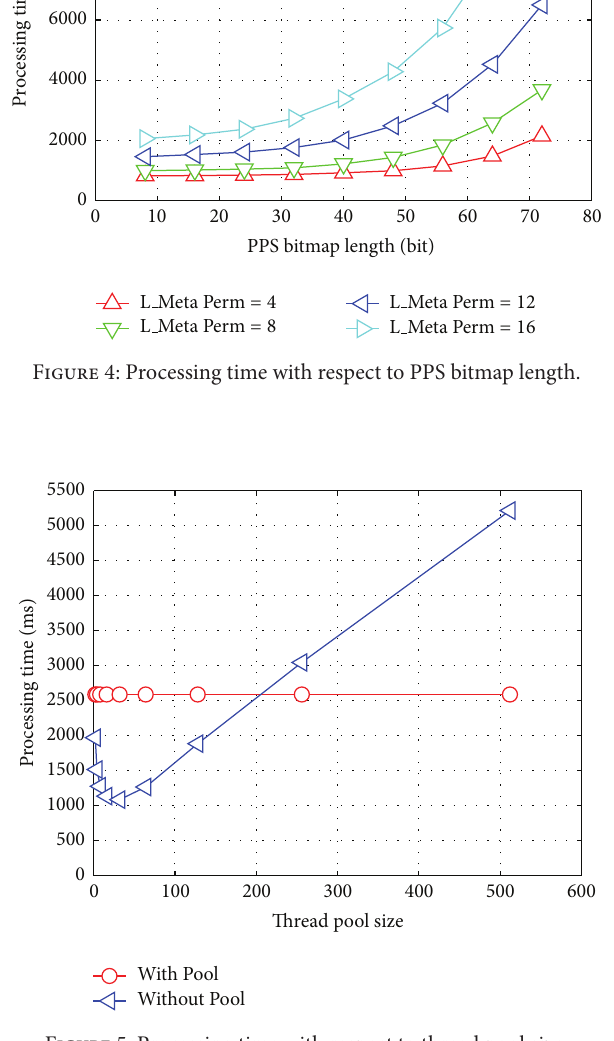
Figure 5: Processing time with respect to thread pool size.